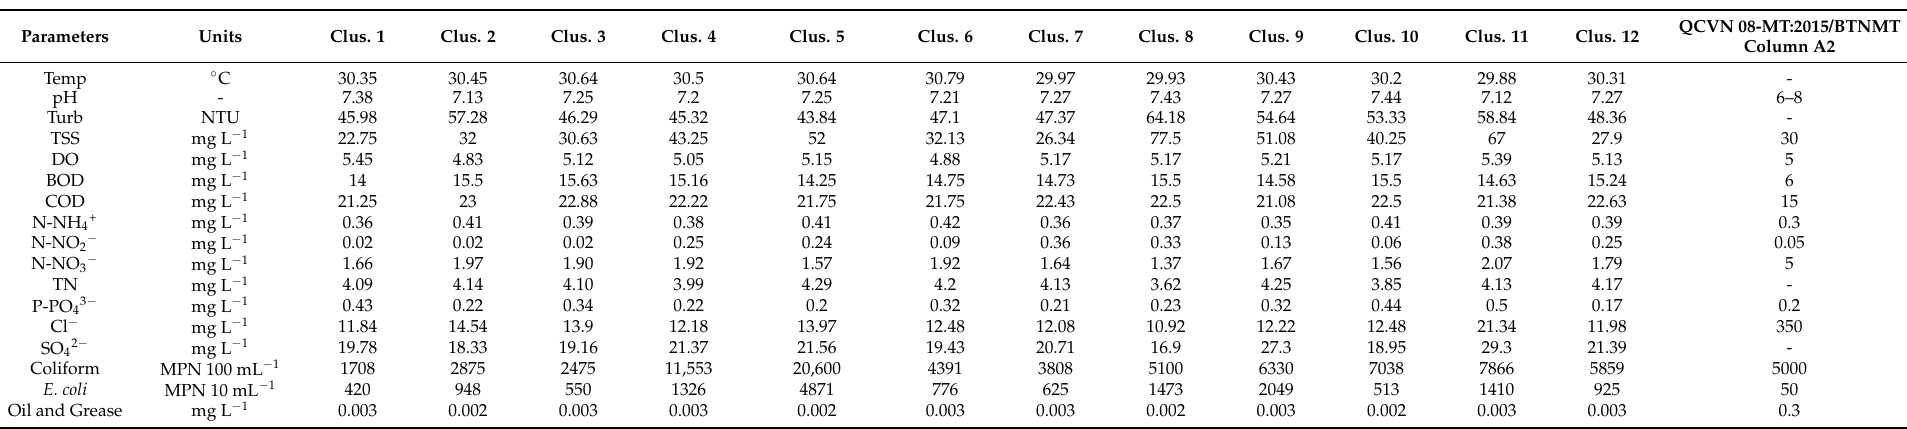
Table 3. Mean values of water parameters in the identified